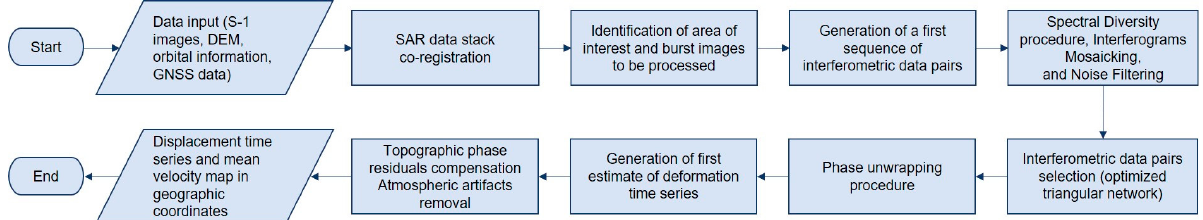
Figure 3. Flowchart of the P ‐ SBAS processing chain. Modified from [50,51].